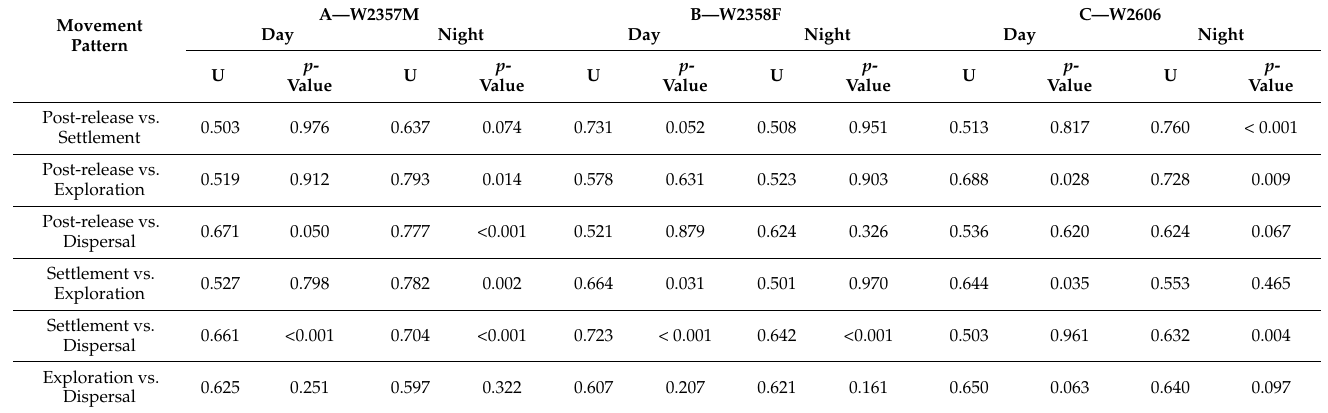
Table 3. Differences in diurnal and nocturnal step lengths between different movement patterns of three GPS-collared wolves in Northern Italy, 2019–2021. U = Mann–Whitney test.